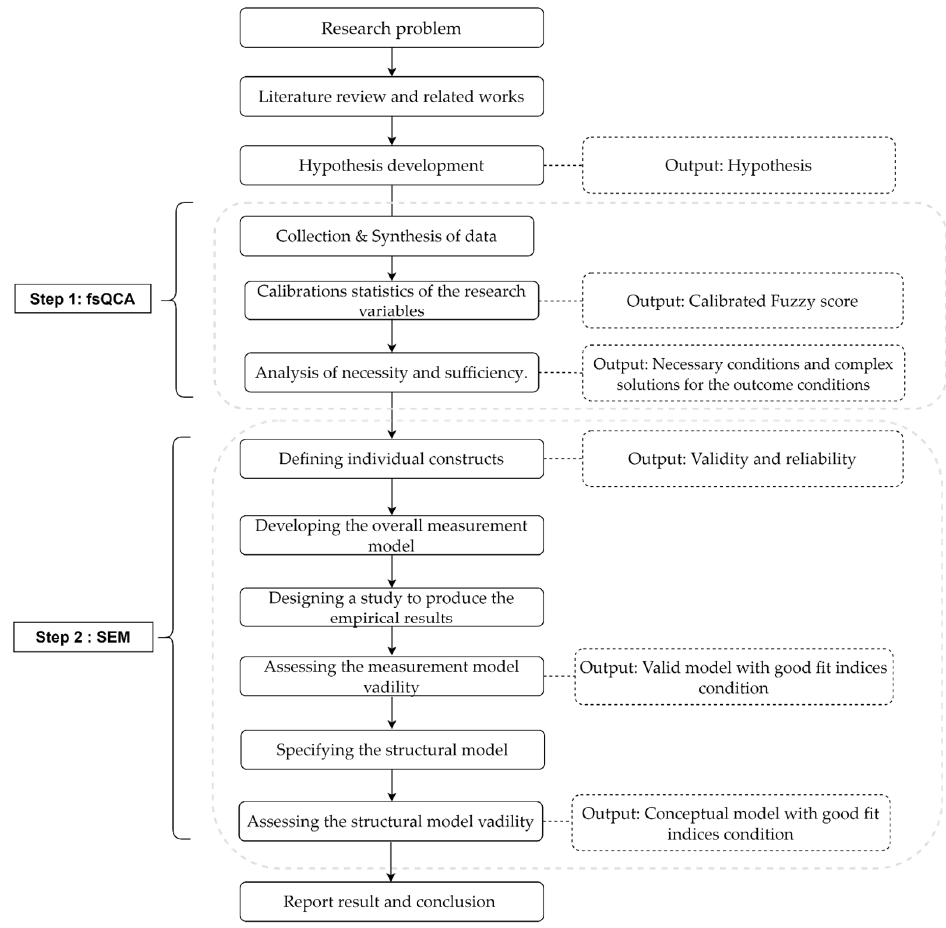
Figure 2. The research methodology.